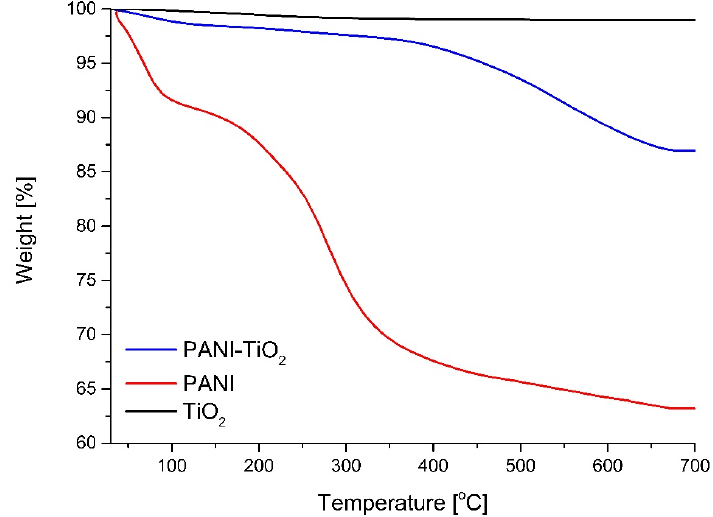
Figure 6. Thermogravimetric analysis (TGA) curve of TiO 2 , PANI, and PANI–TiO 2 nanocomposite.